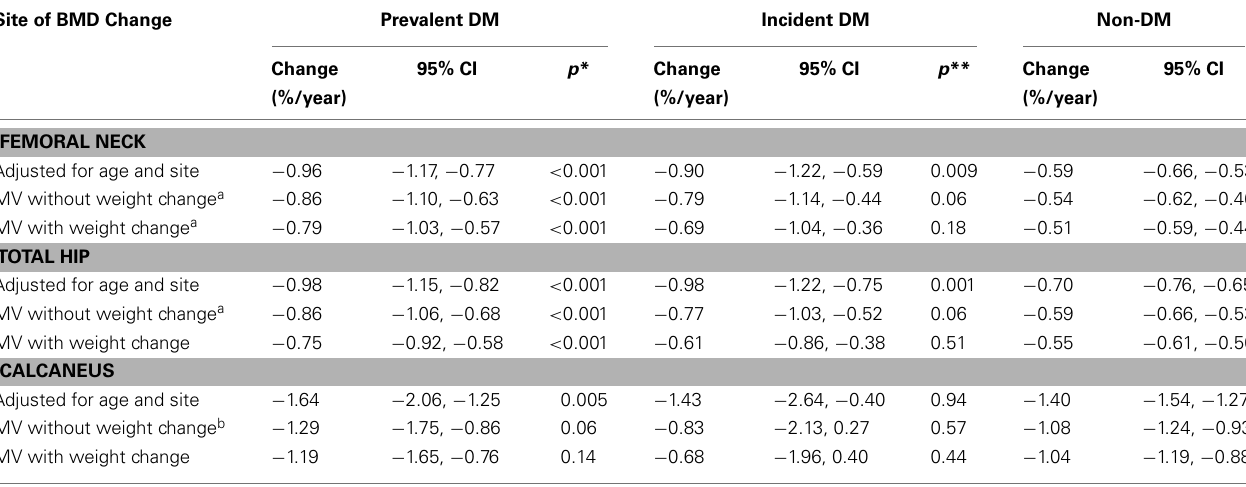
Table 2 |Adjusted mean BMD change at the hip and calcaneus by diabetes status.